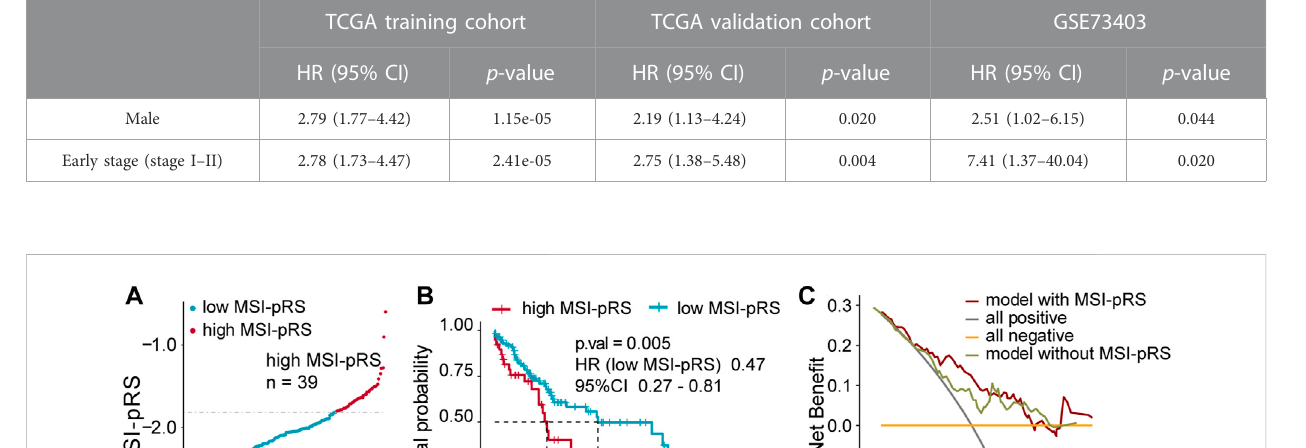
FIGURE 7 Validation of MSI-related prognostic risk score (MSI-pRS) in the internal test cohort (TCGA test cohort). (A) TCGA LUSC test cohort was divided into two groups according to MSI-pRS. (B) Kaplan-Meier curves of the high MSI-pRS and low MSI-pRS groups in TCGA LUSC test cohort. (C) Decision curves of the multivariate Cox model with or without MSI-PRS. The model with MSI-pRS declared a better performance than the model without the MSI-pRS group. (D) Receiver operating characteristic (ROC) curves at years 1, 3, and 5 of the model including age, tumor stage, and MSI-pRS group. (E and F) Calibration curves of the model, including age, tumor stage, and MSI-pRS